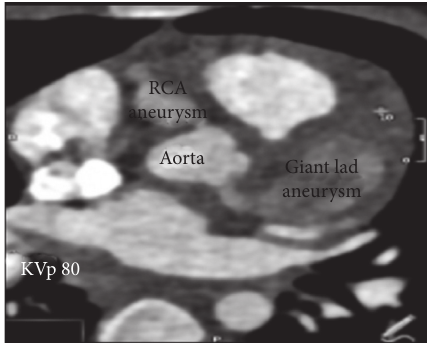
Figure 6: CT angiography showing massive LAD